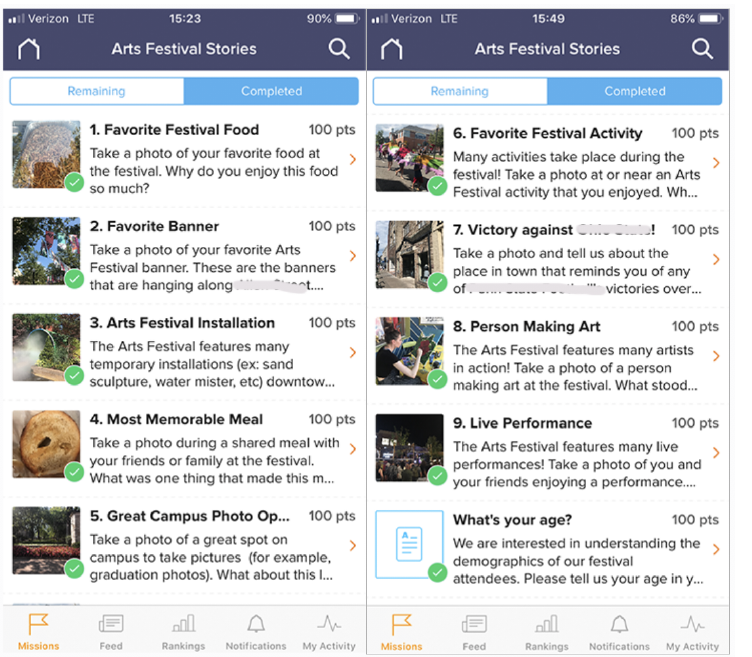
Figure 3. Mobile Scavenger Hunt Mission